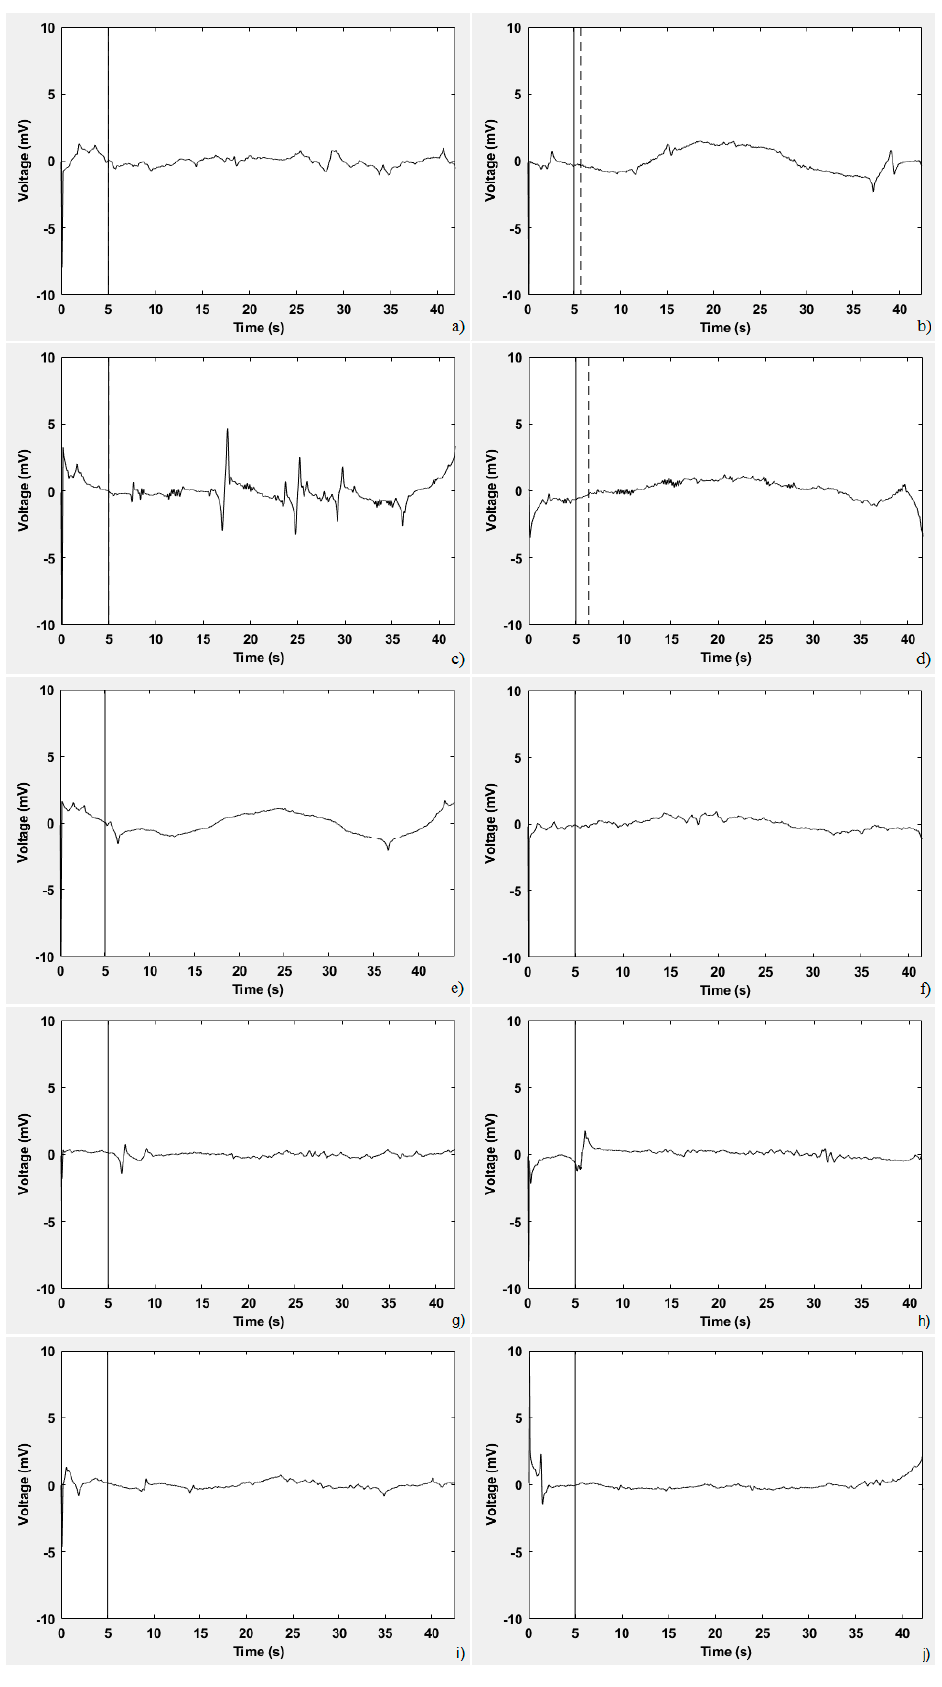
Figure 9. EOG-processed signals obtained by the ten subjects (a–j in Table 1) involved in the tests.